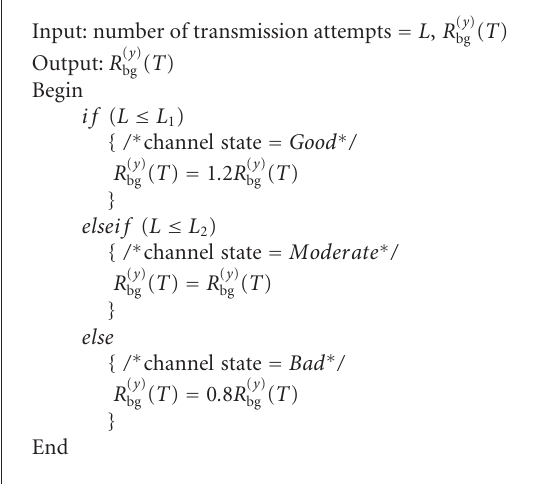
Algorithm 1: Refining the calculated target transcoding rate.